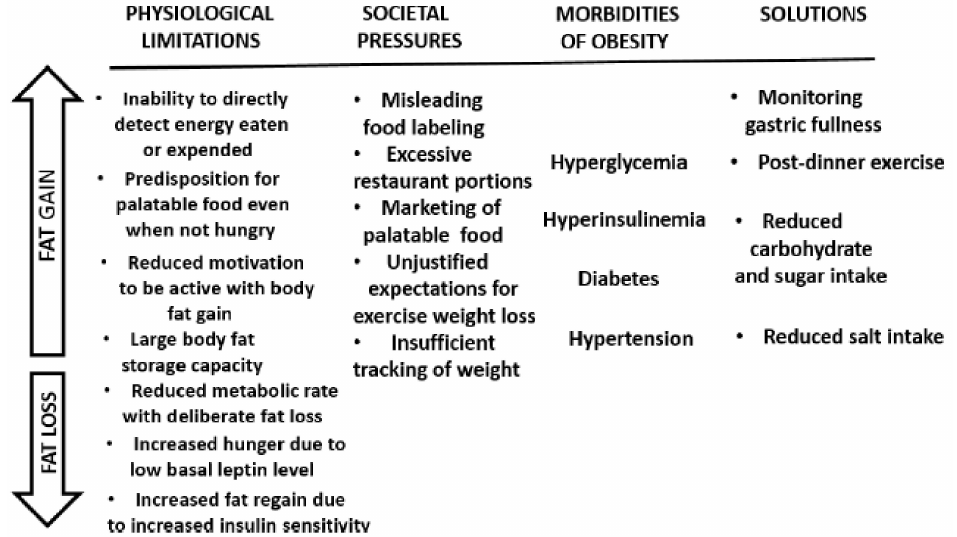
Figure 11. A summary of physiological limitations and some societal pressures facilitating overeating and obesity (upward arrow), and difficulties of losing excess weight (downward arrow). Shown also are some obesity-associated morbidities that can be mitigated by appropriate nutrient